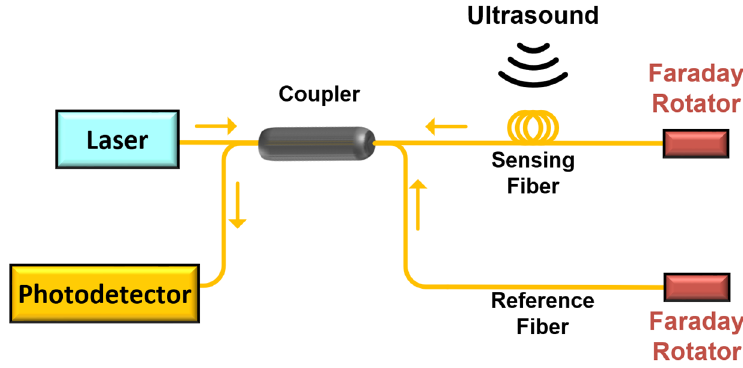
Figure 1. Basic structure based on interference fiber ultrasonic sensing system.